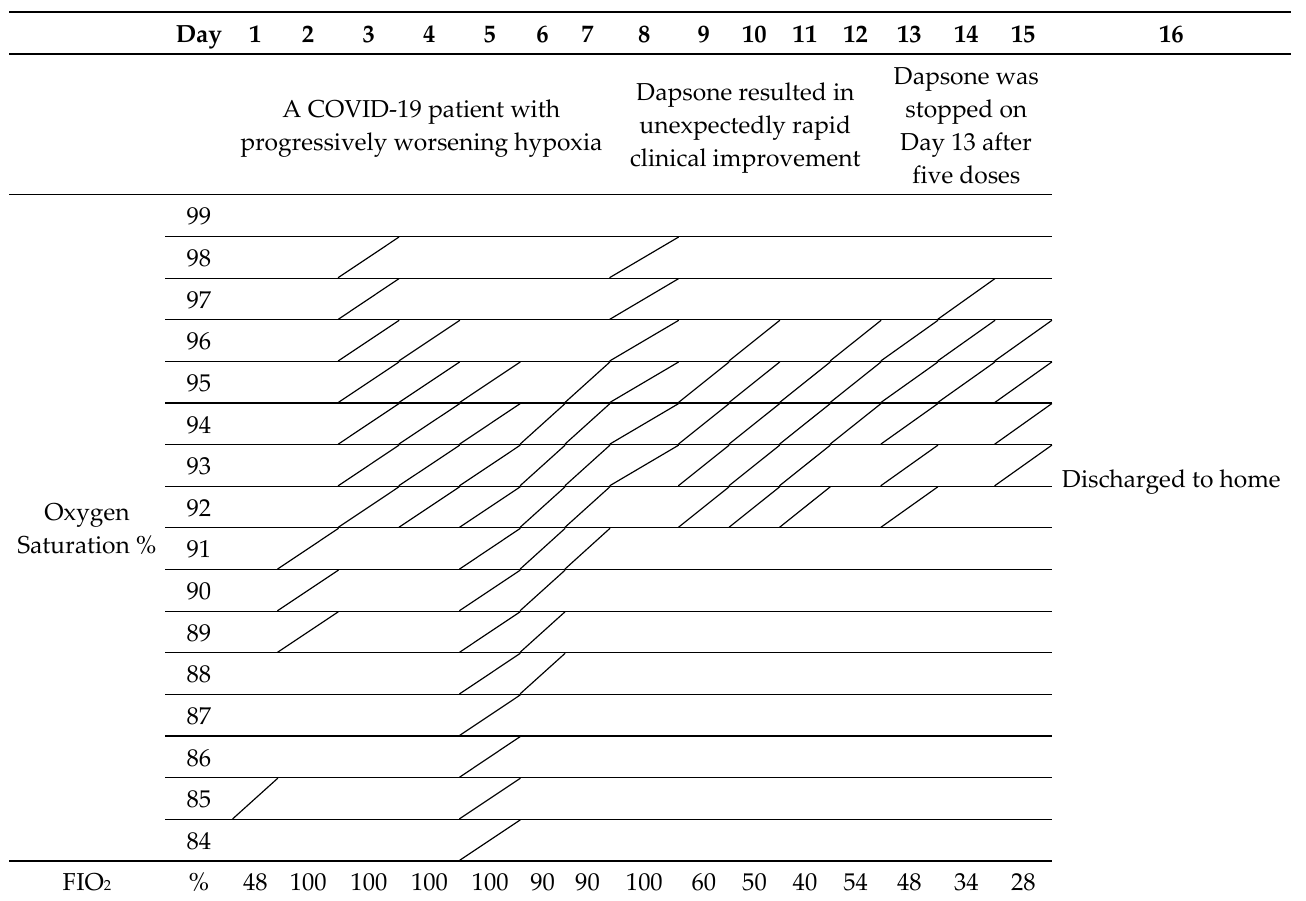
Table 3. O 2 saturation graph (Supplementary Materials Section 2, Case 3).